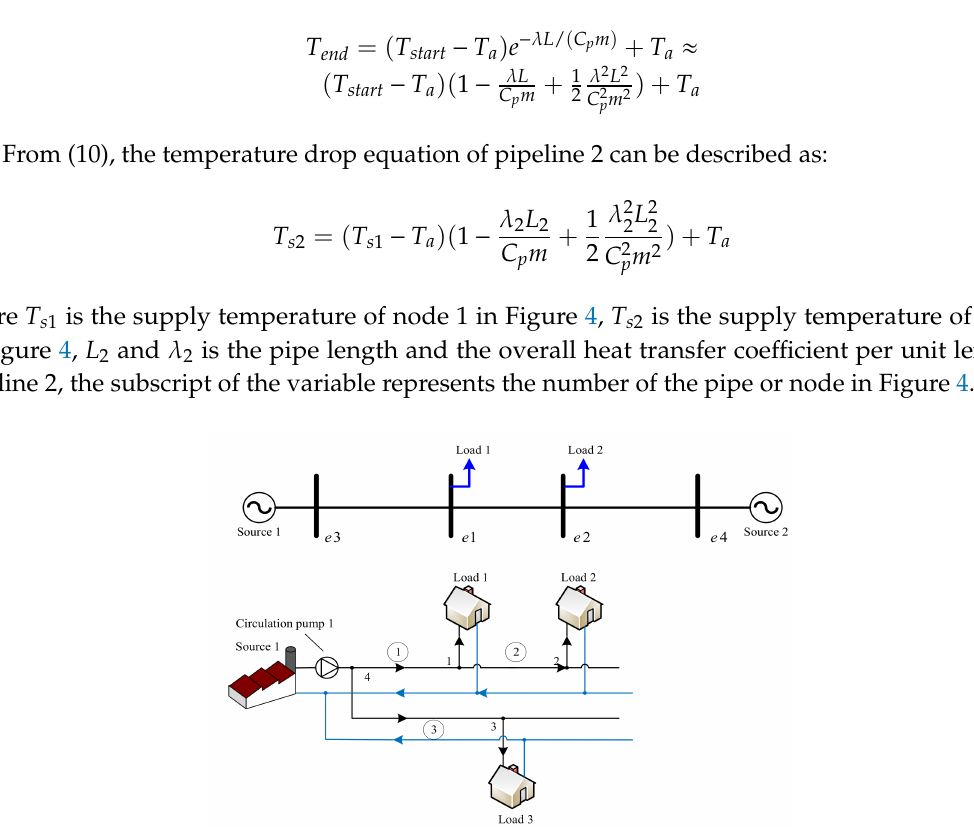
Figure 4. Radiant heating network coupled a simple electricity network (case study